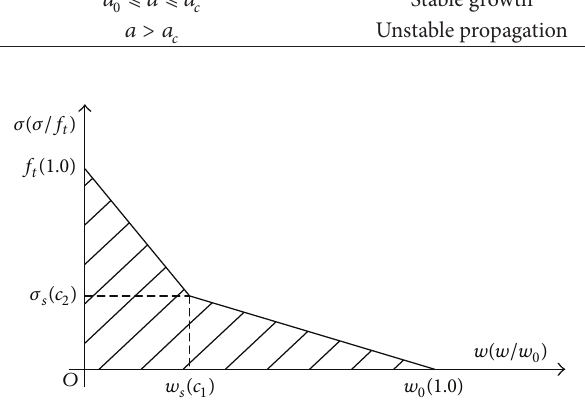
Figure 3: Bilinear cohesive force model of mass